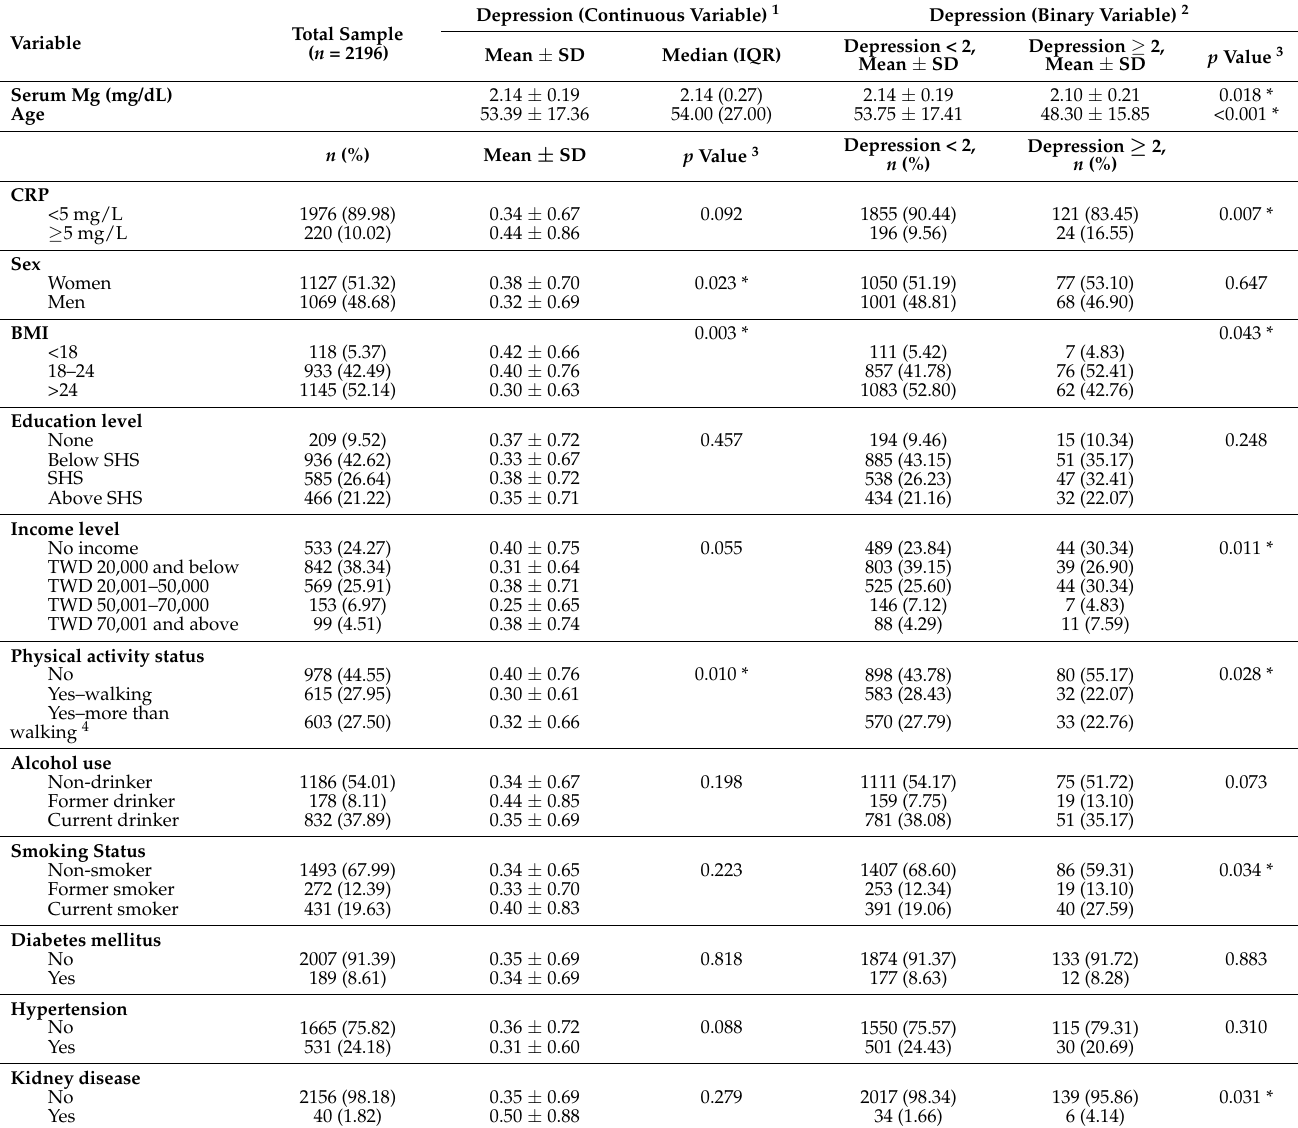
Table 1. Characteristics of predictors by depression score as a continuous or binary